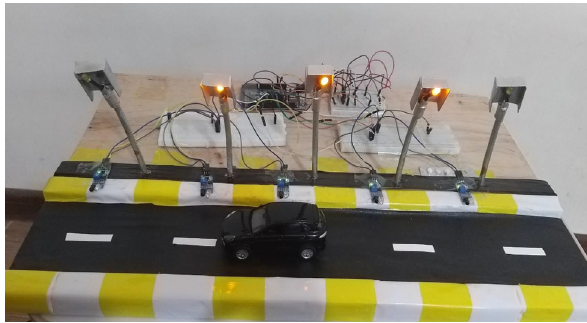
Figure 3: Switching ON of the light column nos. 2, 3, and 4 ON, while 1 and 5 are OFF.